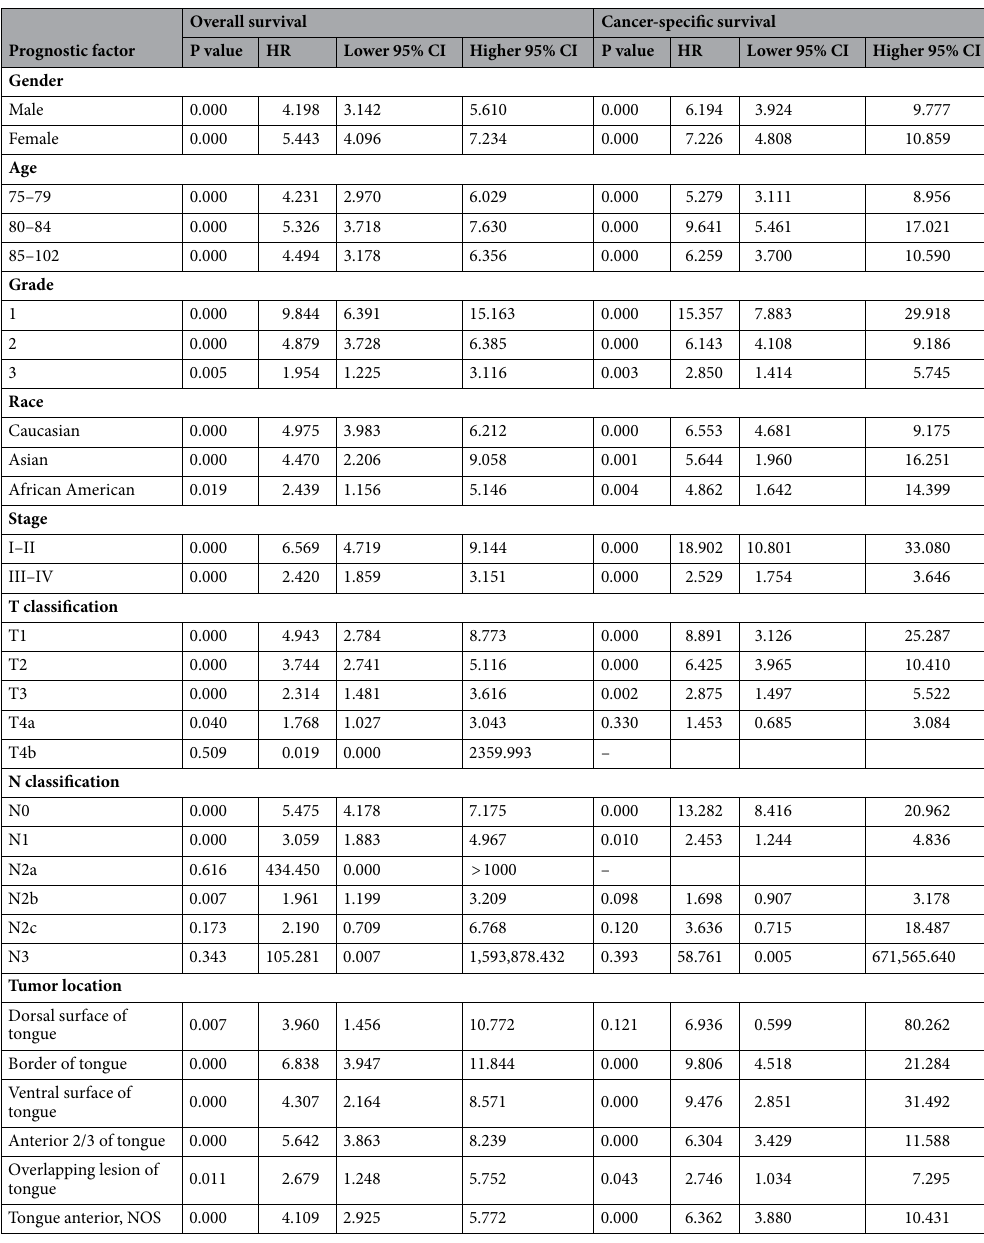
an adjusted Cox proportional-hazards